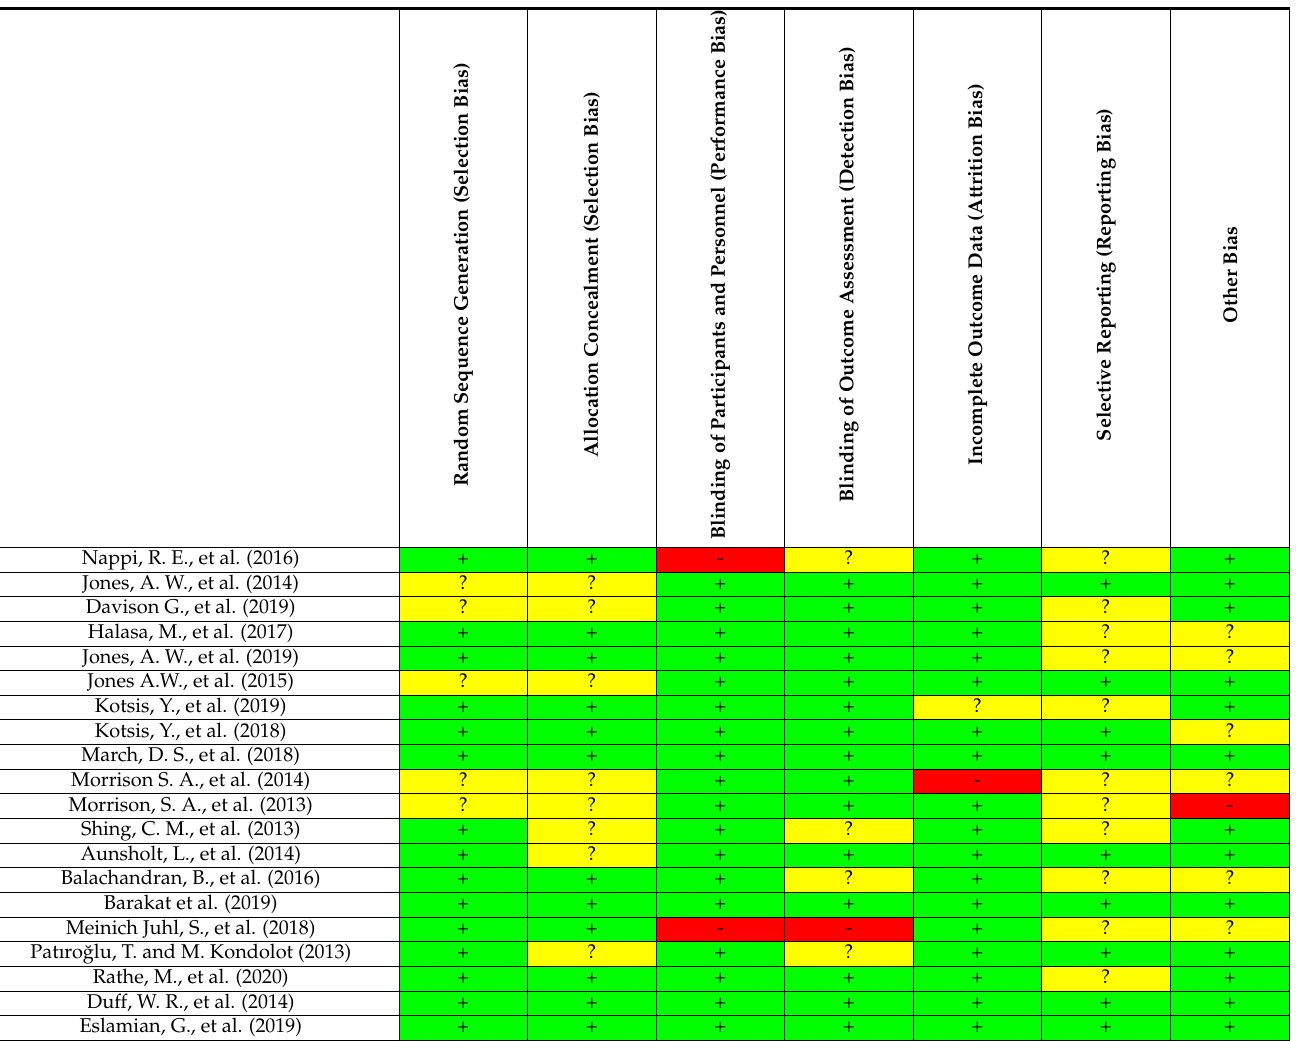
Table 9. CCRBT bias